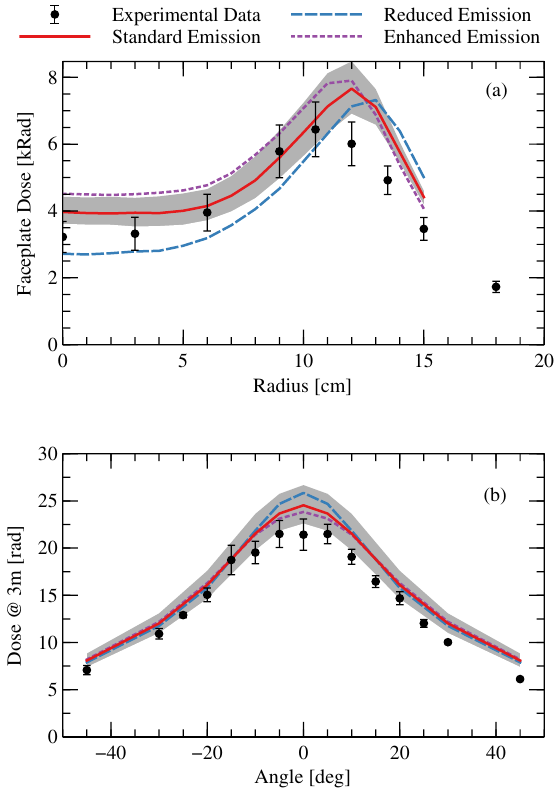
FIG. 12. Comparison of measured (points) and simulated (curves) doses from simulation Case 0 and Cases D3 – D4, in (a) the near field and (b) the far field. Changes in electron emission from the cathode hemisphere causes: (a) changes in the on-axis faceplate dose and peak radius of annular beam, and (b) slight changes to the peak shape of the angular distribution of the far-field